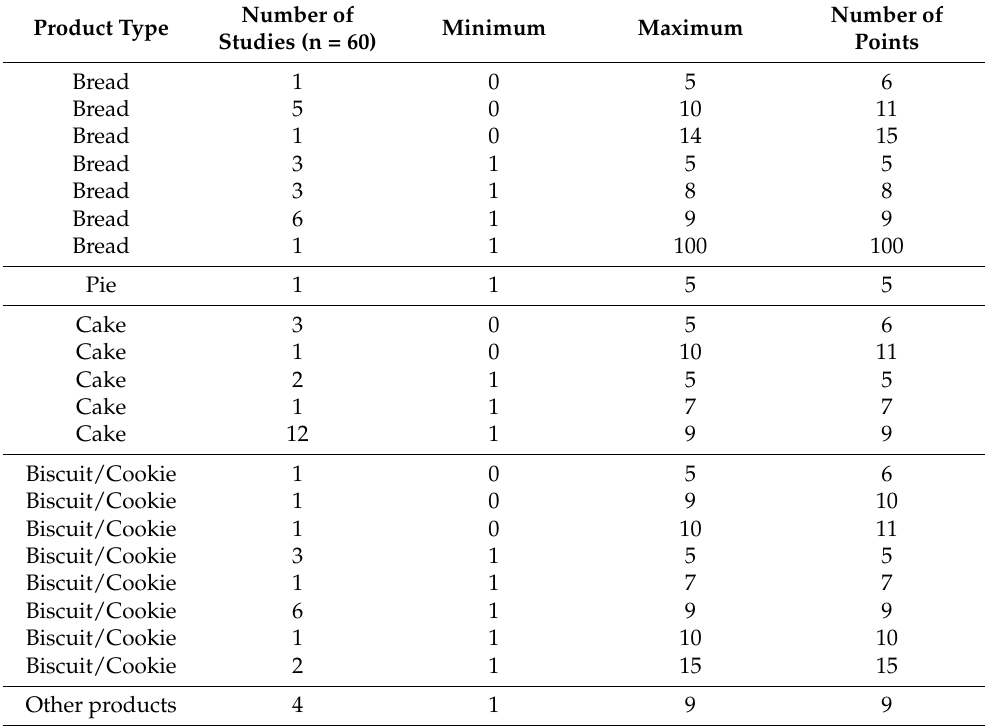
Table 6. Characteristics of hedonic scales used in sensory analysis of bakery products.